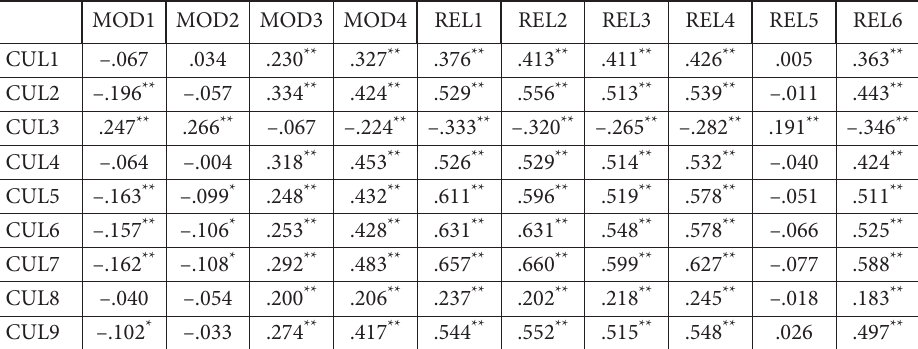
Table 2. Coefficients of correlation between the organizational culture dimensions and the CMPR dimensions and the OPR dimensions